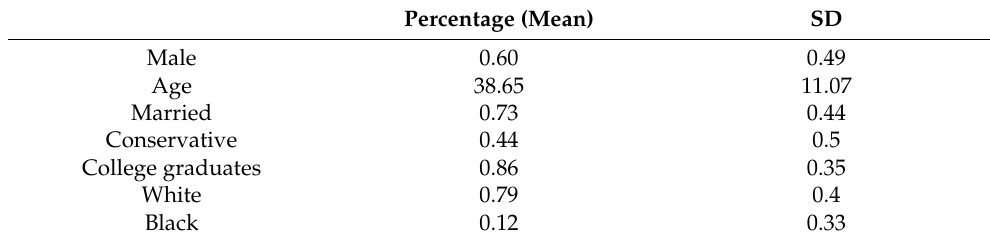
Table 2. Descriptive statistics.